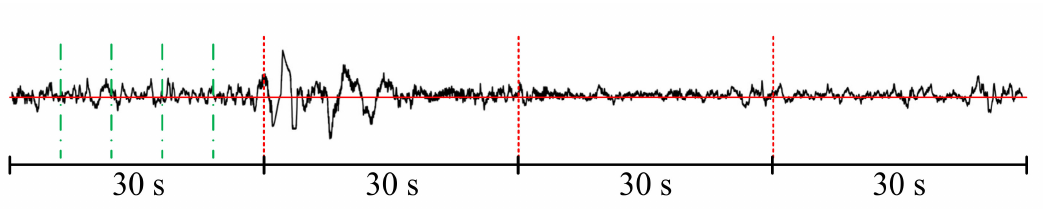
Figure 1. Time domain level division of physiological